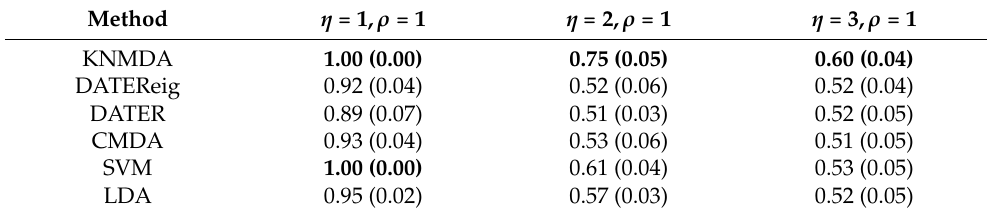
Table 1. CP data with r 1 = 3, r 2 = 3, size 10 × 10 × 10. Different columns report AUC (and standard deviation) for different levels of noise. The bold values represent the best performance for each column.